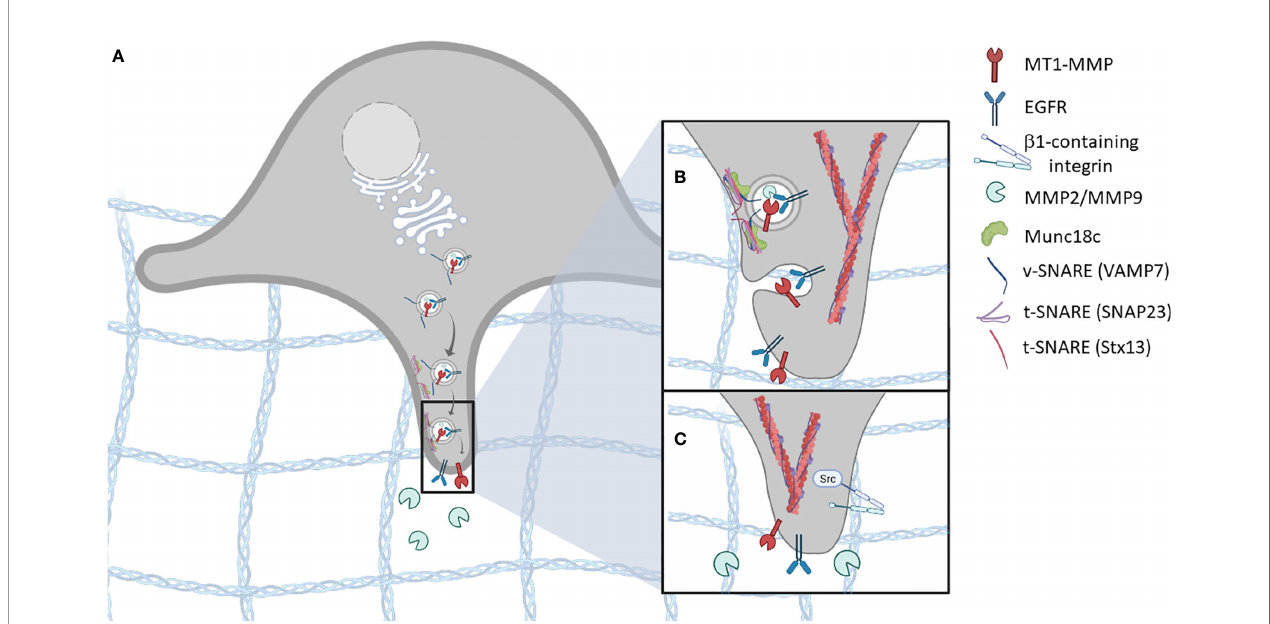
FIGURE 1 | SNARE-mediated vesicle traf fi cking of invadopodium-associated proteins is essential for invadopodia formation. (A) vesicles containing invadopodial proteins, such as MT1-MMP, EGFR, and MMP2/MMP9, are traf fi cked to invadopodia pre-cursor sites. (B) As the vesicle comes in proximity to the target membrane, a SNARE complex is formed, involving t-SNAREs (Stx13, SNAP23) and v-SNAREs (VAMP7), that facilitates membrane fusion. (C) Membrane fusion results in the localization of invadopodium-associated proteins, at sites of ECM invasion. Additional invadopodial proteins are traf fi cked in a similar manner, including b 1- containing integrins, which mediate downstream signaling pathways and promote invadopodia-based